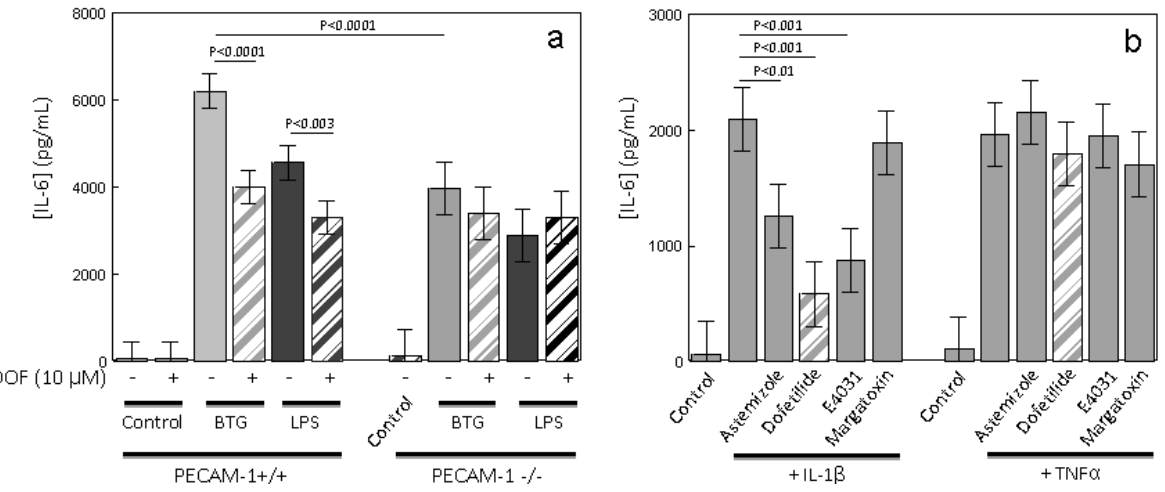
FIGURE 4. The effect of Kv11.1 inhibitors on IL-6 secretion by wild-type and PECAM-1 –/– RPMΦ. (a) Effect of DOF on IL-6 secretion by wild-type and PECAM-1 –/– RPMΦ in response to a variety of phlogistic agents. Supernatants were collected from PECAM-1 +/+ (n = 5) or PECAM-1 –/– (n = 3) RPMΦ cultured in vitro and exposed for 4 h to either BTG (1%) or LPS (10 ng/mL), where DOF (10 μM) may also have been present. Control represents results in the absence of an agonist. (b) Alternatively, RPMΦ from wild-type mice (n = 4) were cultured in vitro and exposed to either IL-1β (10 ng/mL) or TNFα (40 ng/mL) in the presence of either DOF (10 μM), E4031 (40 μM), astemizole (1 μM), or margatoxin (0. 1 μM). Levels of IL-6 were determined by ELISA (DuoSet). Data represent the mean ± 95% CI where no less than three replicates were performed for each individual mouse and where the supernatant was assayed neat and at 1:2 and 1:4 dilutions with final concentrations determined from the slope of a curve.